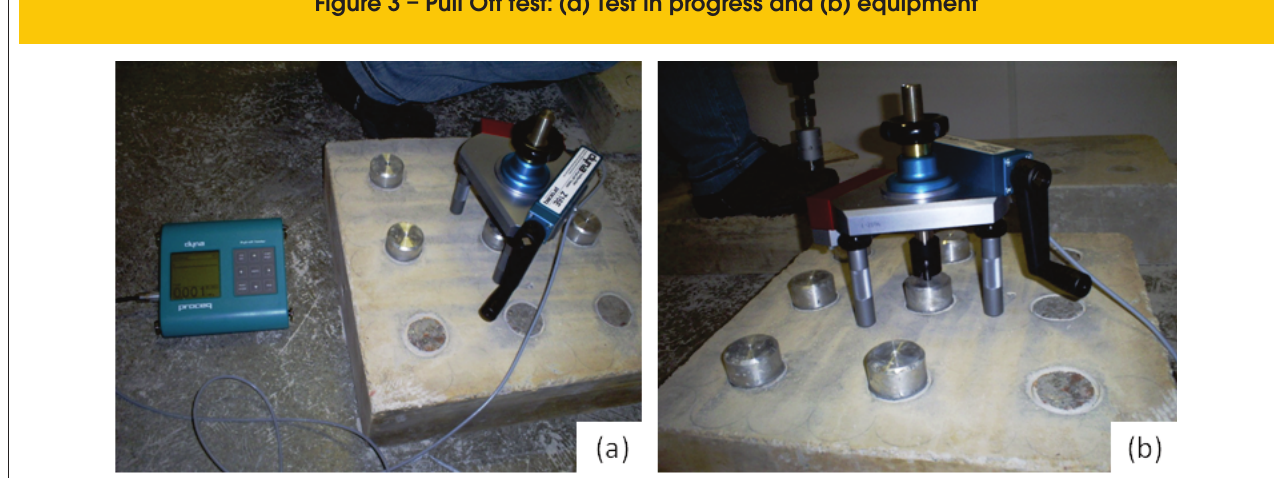
Figure 3 – Pull Off test: (a) Test in progress and (b)